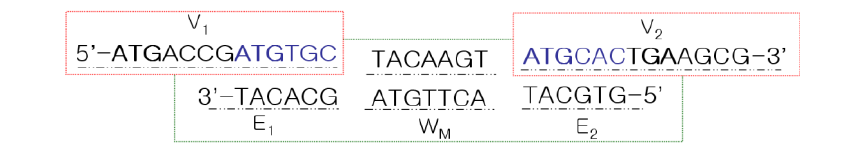
Figure 4. An example of path creation containing a